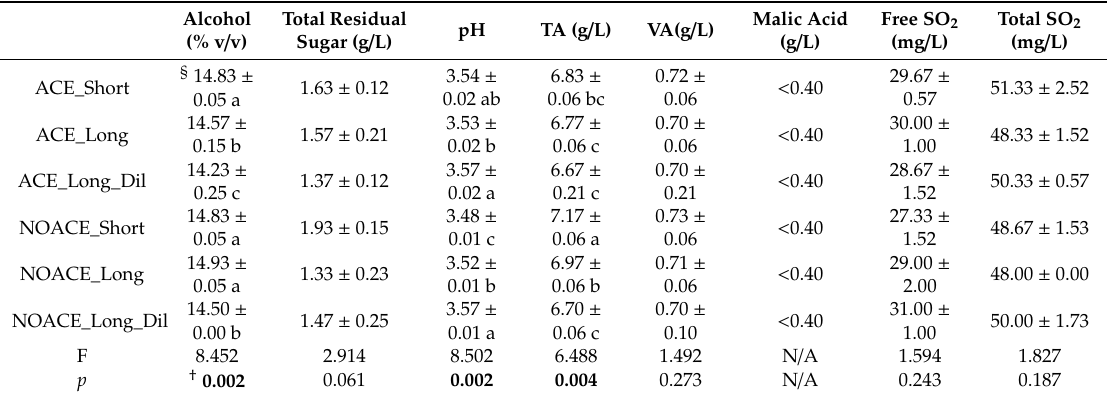
Table 1. Basic chemical composition of the Shiraz wines prepared following NOACE and ACE maceration with either 3 days (Short) or 6 days (Long) on skins, or 6 days on skins with pre-fermentation water dilution to 13.5 B é